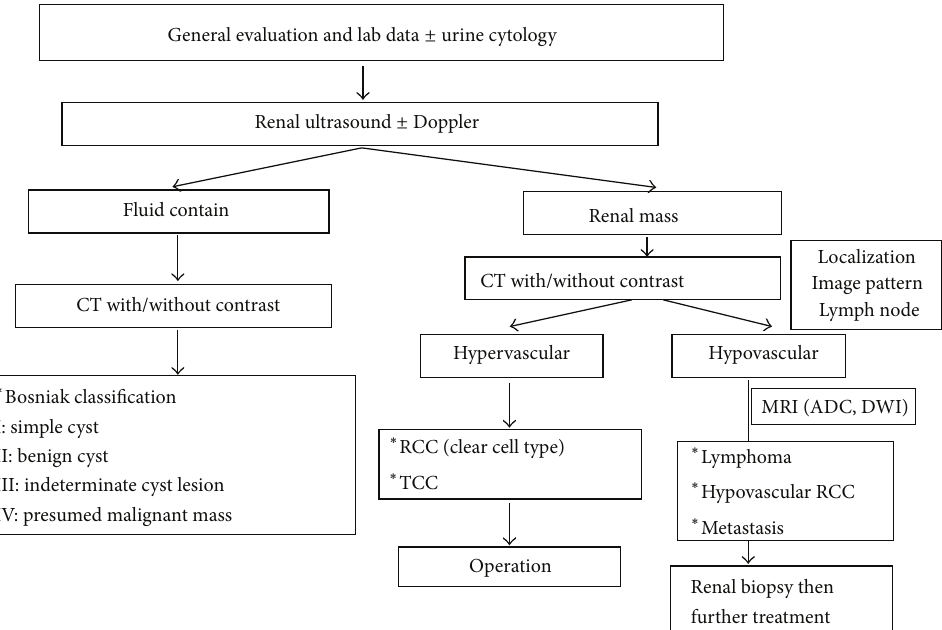
Figure 4: Summary of imaging survey of a renal mass. Initial imaging survey for renal mass is renal echo and if renal echo showed a renal solid mass and the next imaging survey is abdominal CT scan with/without enhancement. CT scan can detect tumor localization, imaging pattern, and lymph node involvement. If a hypovascular renal tumor is found, MRI image can help differential diagnosis the etiology. If MRI image reveals the diagnosis of lymphoma, renal biopsy is